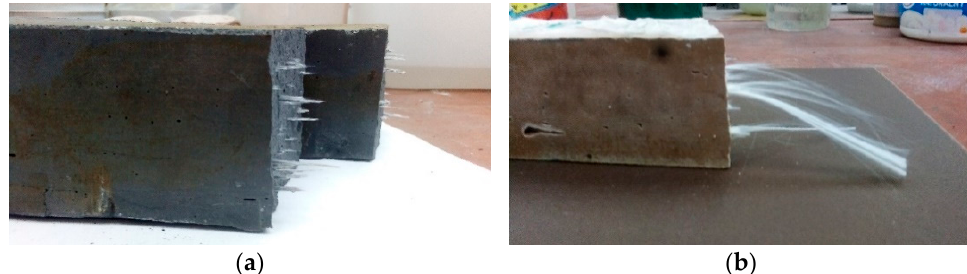
Figure 12. Changing the behavior of glass fibers placed in various geopolymer matrices: ( a ) fly ash-based matrix; ( b ) metakaolin-based matrix.